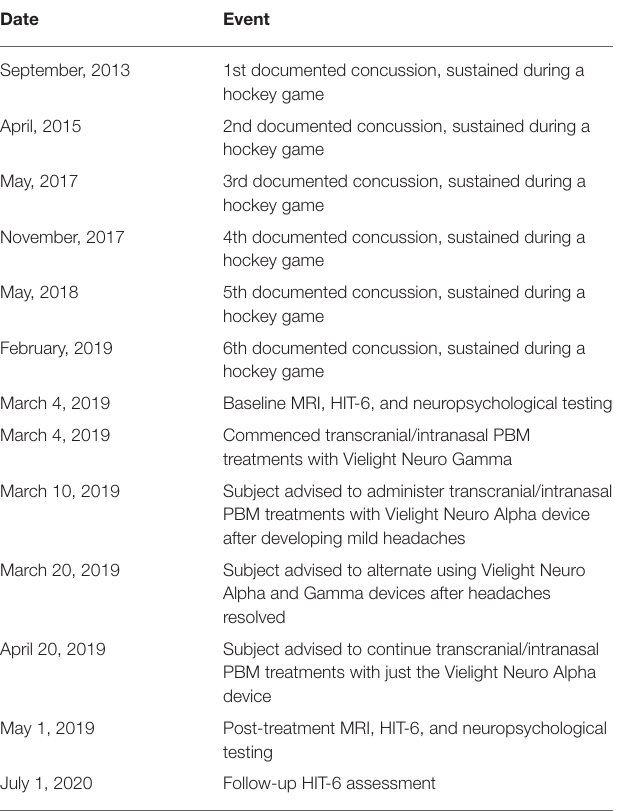
TABLE 1 | Timeline of the subject’s concussions, PBM treatments, and